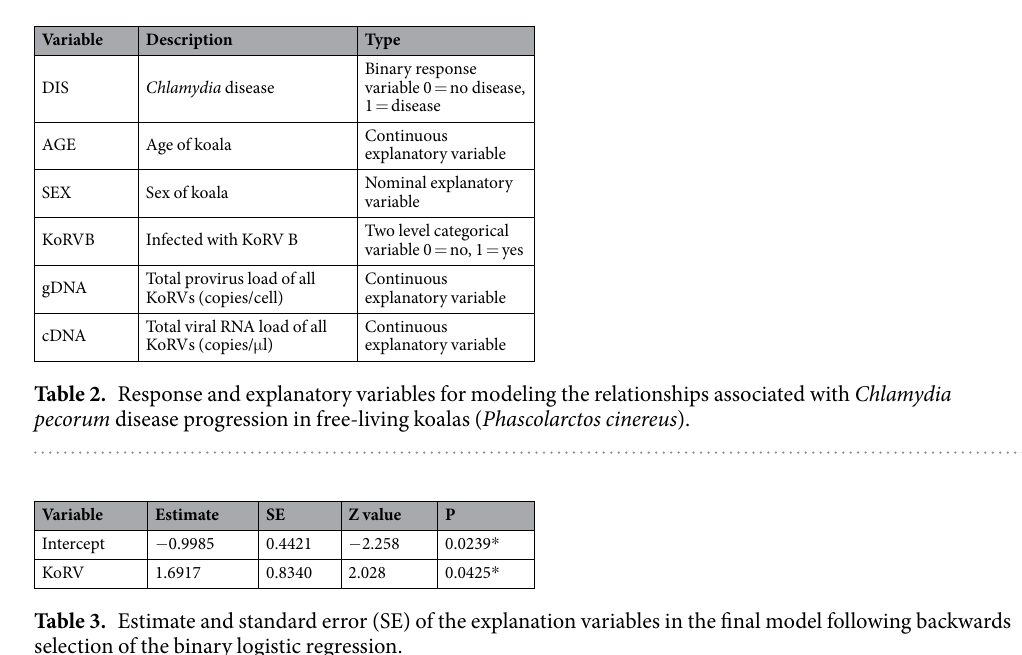
progression to disease. In the “infected, no disease” group 100% were infected with ompA genotype G, indicating that ompA genotype G alone is not independently virulent. In the diseased group, 44% of animals were infected with ompA genotype G, with 5 of the 9 diseased animals infected with other genotypes; three were infected with ompA genotype E’, one animal with ompA genotype F, and one animal with ompA genotype A (Fig. 5). A